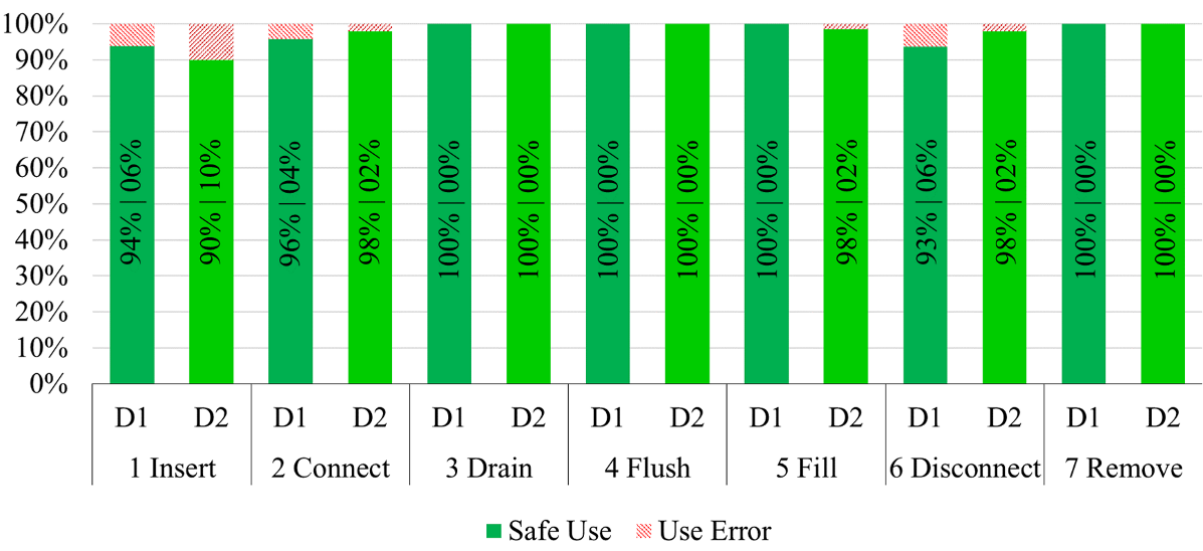
Figure 5. Comparison of task performance between D1 and D2 for all seven tasks. Evaluation in two categories, safe use and use error, according to International Electrotechnical Commission 62366-1